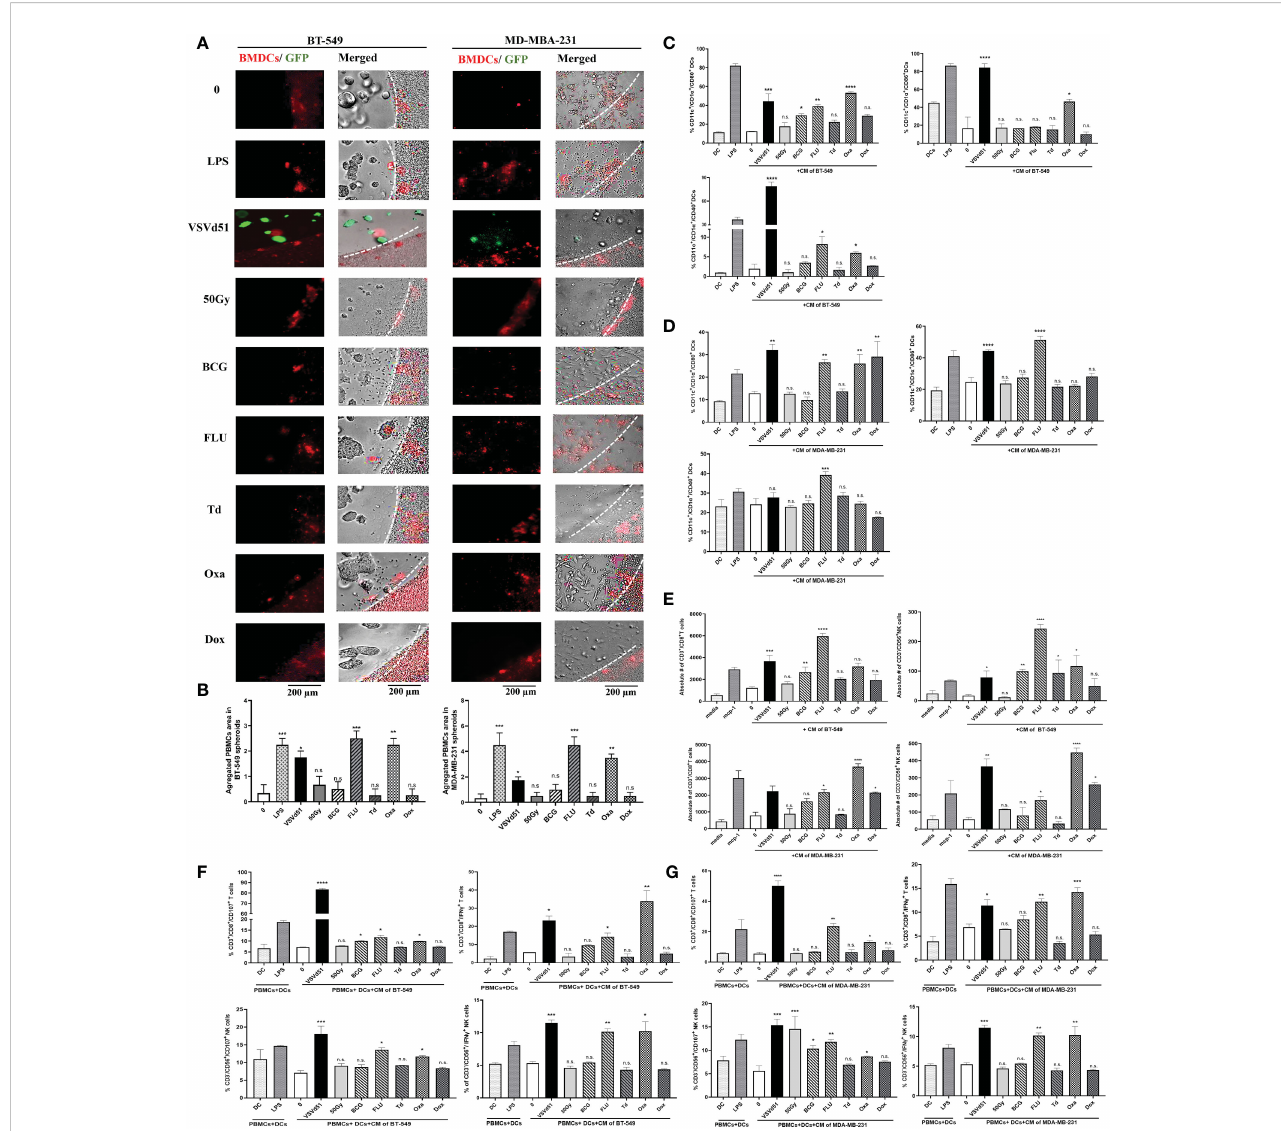
FIGURE 4 Increased migration and functionality of human DC and effector immune cells following co-culture with oxaliplatin and in fl uenza vaccine treated human TNBC spheroids. Live cell images from (A) BT-549 and MD-MBA-231 spheroids co-cultured with deep red CellTracker-labelled human DCs, 24h following their treatment with ICD inducers at IC50 concentrations. LPS (1 m g/ml) treated spheroids were used as positive controls. (B) Quanti fi cation of microscopy images representing the number of in fi ltrated and aggregated immune cells around the treated spheroids. Dashed lines delineate the edge of spheroids. The results are compared to non-treated cells. Flow cytometry analysis of maturation markers on human DCs following 48h of exposure to CM of (C) BT-549 or (D) MDA-MB- 231 cells treated with indicated ICD inducers at IC50 concentration or 10 MOI of VSVd51. LPS treated (1 m g/ml) human DCs are used as a positive control. (E) Flow cytometry quanti fi cation of migrated puri fi ed human CD3 + /CD8 + T cells and CD3 - /CD56 + NK cells towards CM from BT-549 and MDA-MB-231 cells incubated with indicated treatments; MCP-1 (50ng/ml) was used as a positive control for immune cell migration. Flow cytometry analysis of puri fi ed human CD3 + /CD8 + T cells and CD3 - /CD56 + NK cells in tri-cultures with human DCs previously exposed to CM from (F) BT-549 or (G) MDA-MB-231 treated spheroids with indicated treatments. The results are compared to non-treated cells. All data are representative of at least three similar experiments where n=3 for technical replicates, *P < 0.05; **P < 0.01; ***P < 0.001; ****P < 0.0001; (n.s., no signi fi